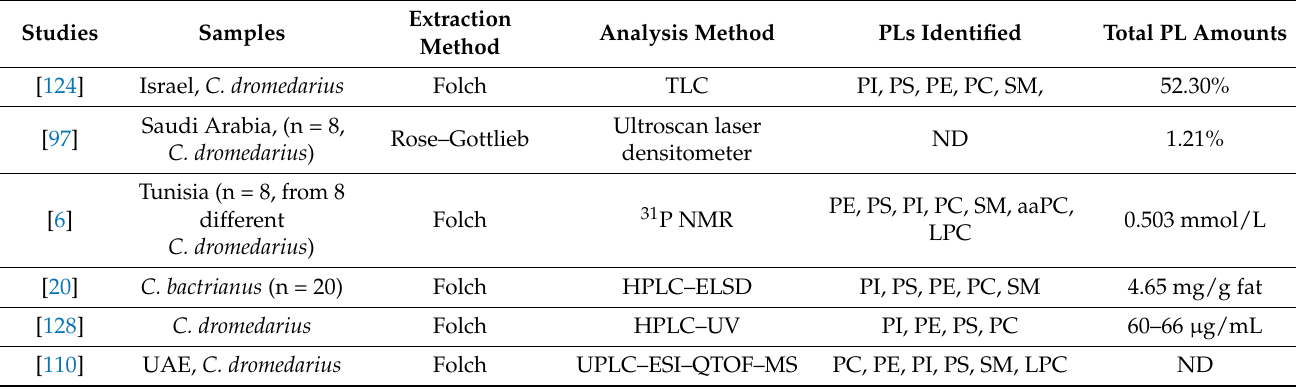
Table 5. Overview of camel milk phospholipid (PL) content and different analytical